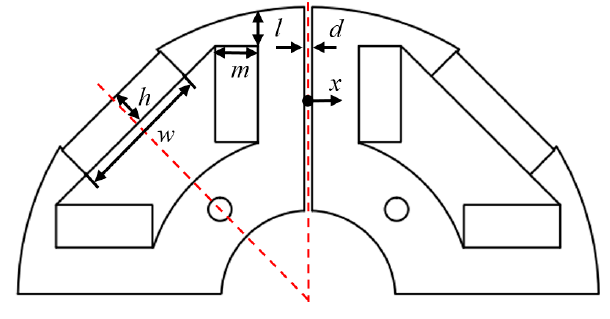
Figure 9. Design variables.